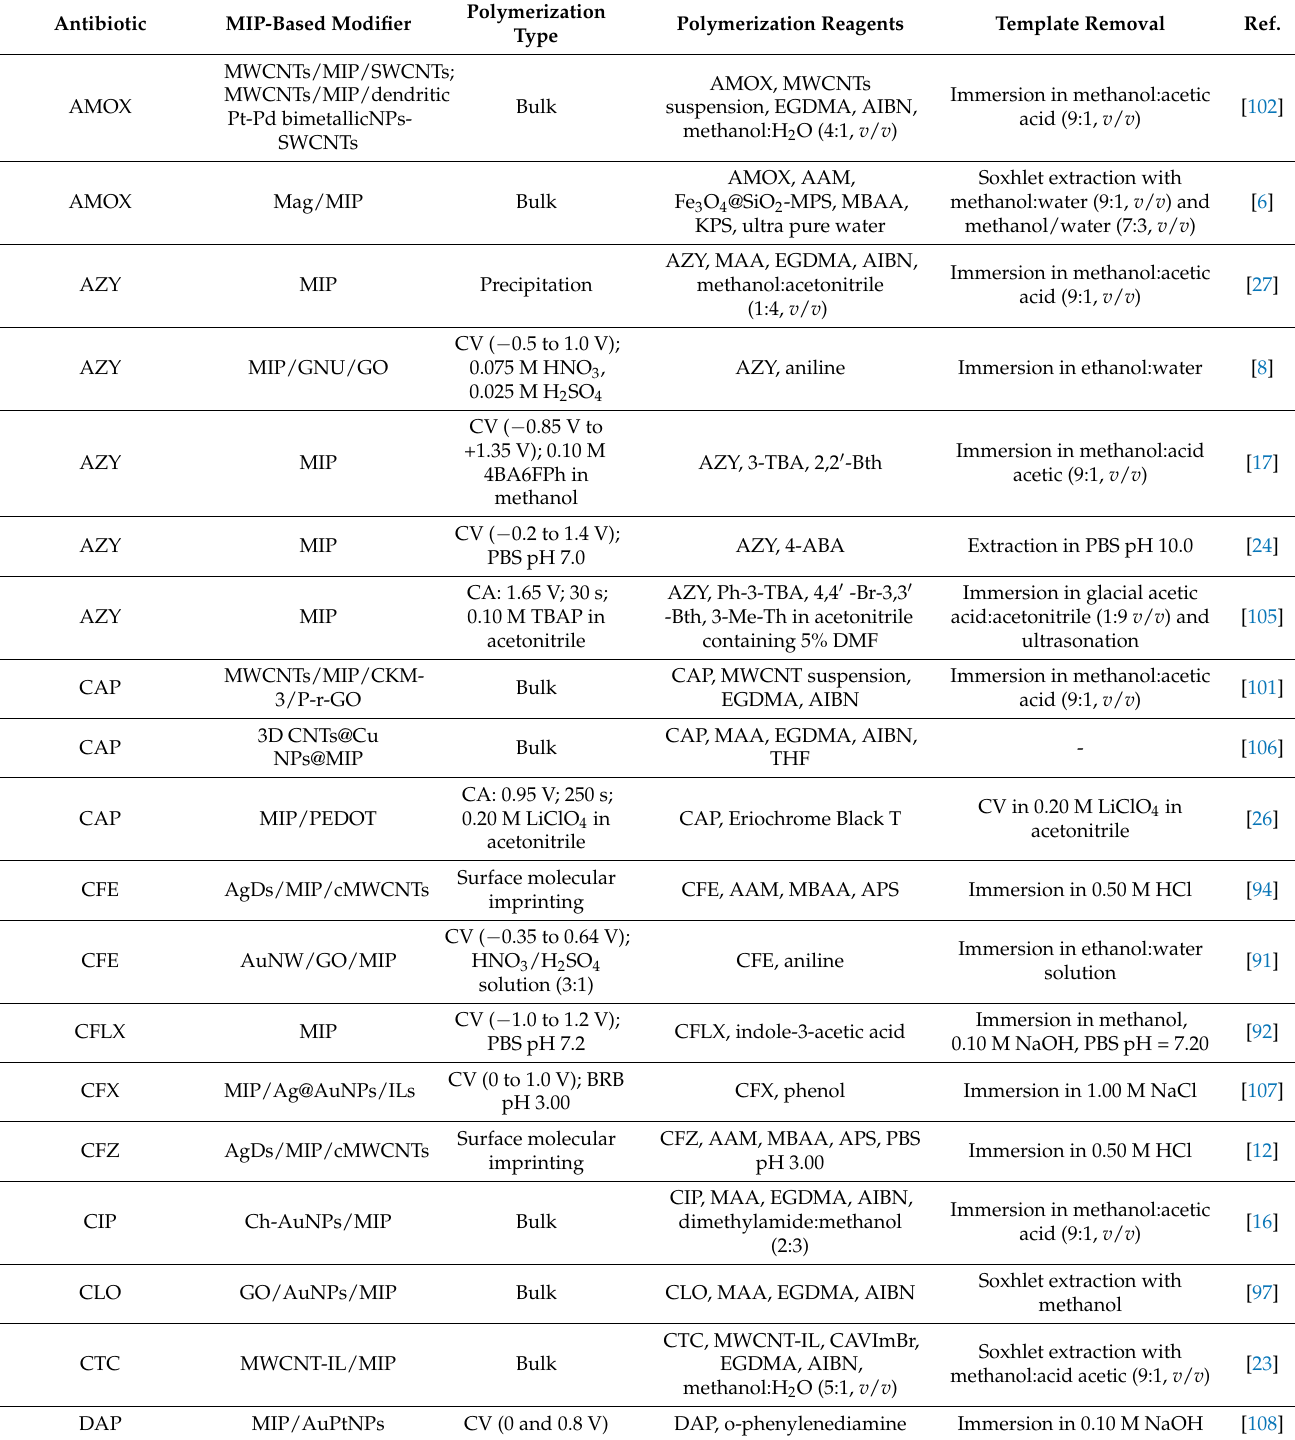
Table 1. Materials and steps involved in the preparation of MIP-based sensors reported for antibiotic